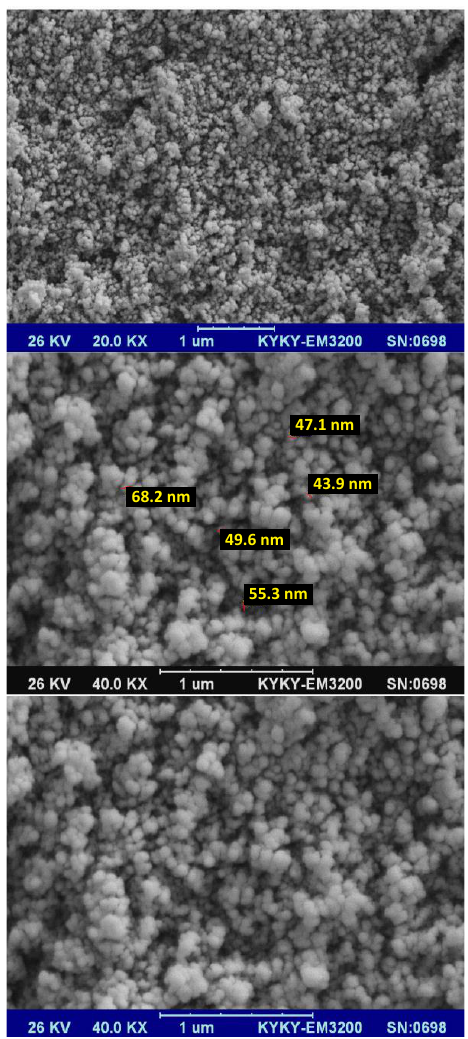
O nanoparticles prepared 2 4 at 900W Fig.5. SEM images of PS-CNT-CuFe